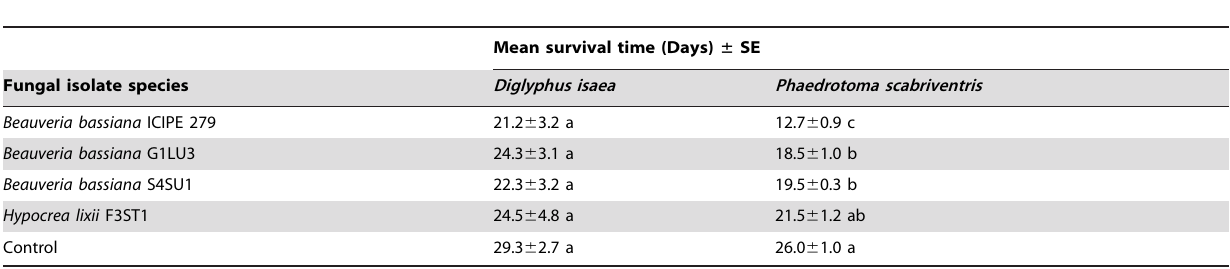
Table 2. Mean survival time of Diglyphus isaea and Phaedrotoma scabriventris adult parents parasitizing Liriomyza huidobrensis following exposure to infested Vicia faba plants endophytically-colonized by the different endophyte fungal